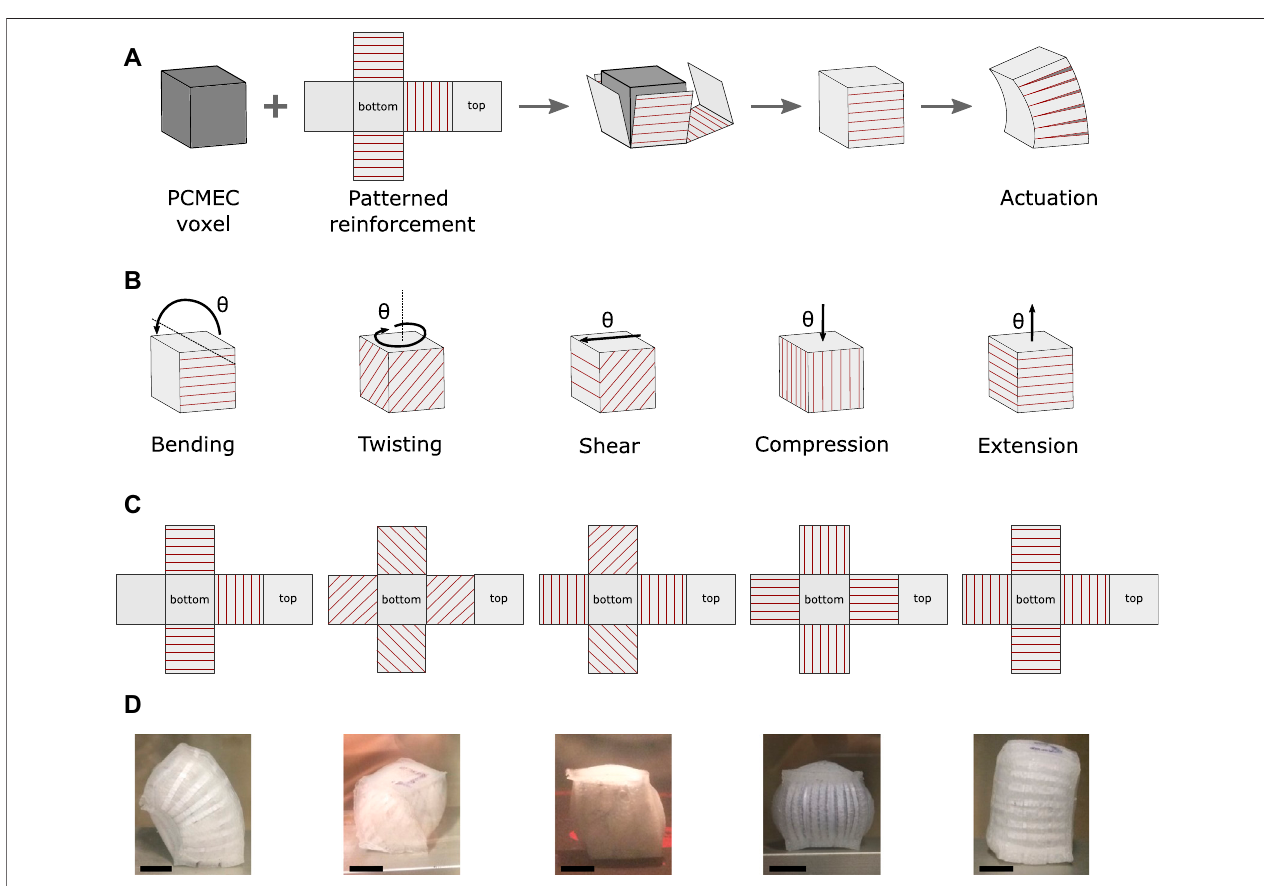
FIGURE 9 | PCMEC voxels. (A) Principle illustrated for bending. The cuts in the paper reinforcement are indicated in red. (B) Elementary kinematics, pure deformations. (C) Kirigami patterns. (D) Experimental results.